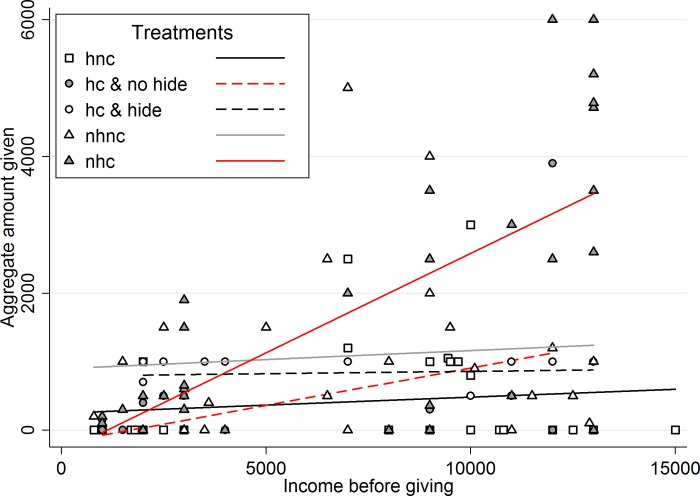
Income before giving vs aggregate amount given of all A types.Colors and linear fits are for the different treatments: hnc is “hide, no claim” (in this case all 30 A subjects decided to hide), nhnc is “no hide, no claim”, nhc is “no hide, claim”, and finally hc is “hide, claim”. In the fourth case 14 A subjects decided to hide, while the other 16 decided not to.